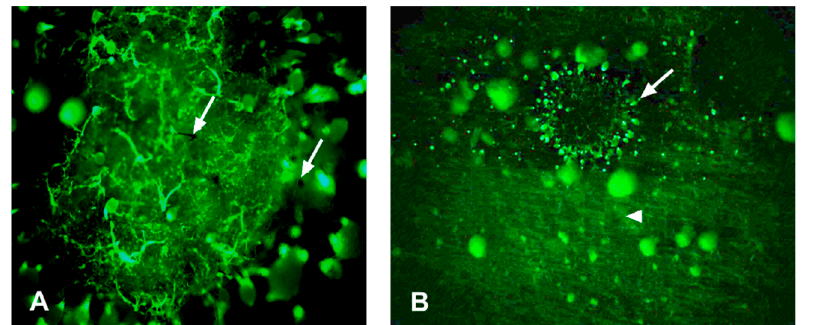
Figure 4. Stereo light micrographs showing the fluorescence of O. piceae on wood wafers: ( A ) Mycelium mass and well developed synnemata (arrows) over untreated wafers; ( B ) non pigmented synnemata of O. piceae fluorescing (arrow) on wafers inoculated with BCA. Mycelium of BCA ( T. harzianum ) auto-fluorescing (arrow-head).